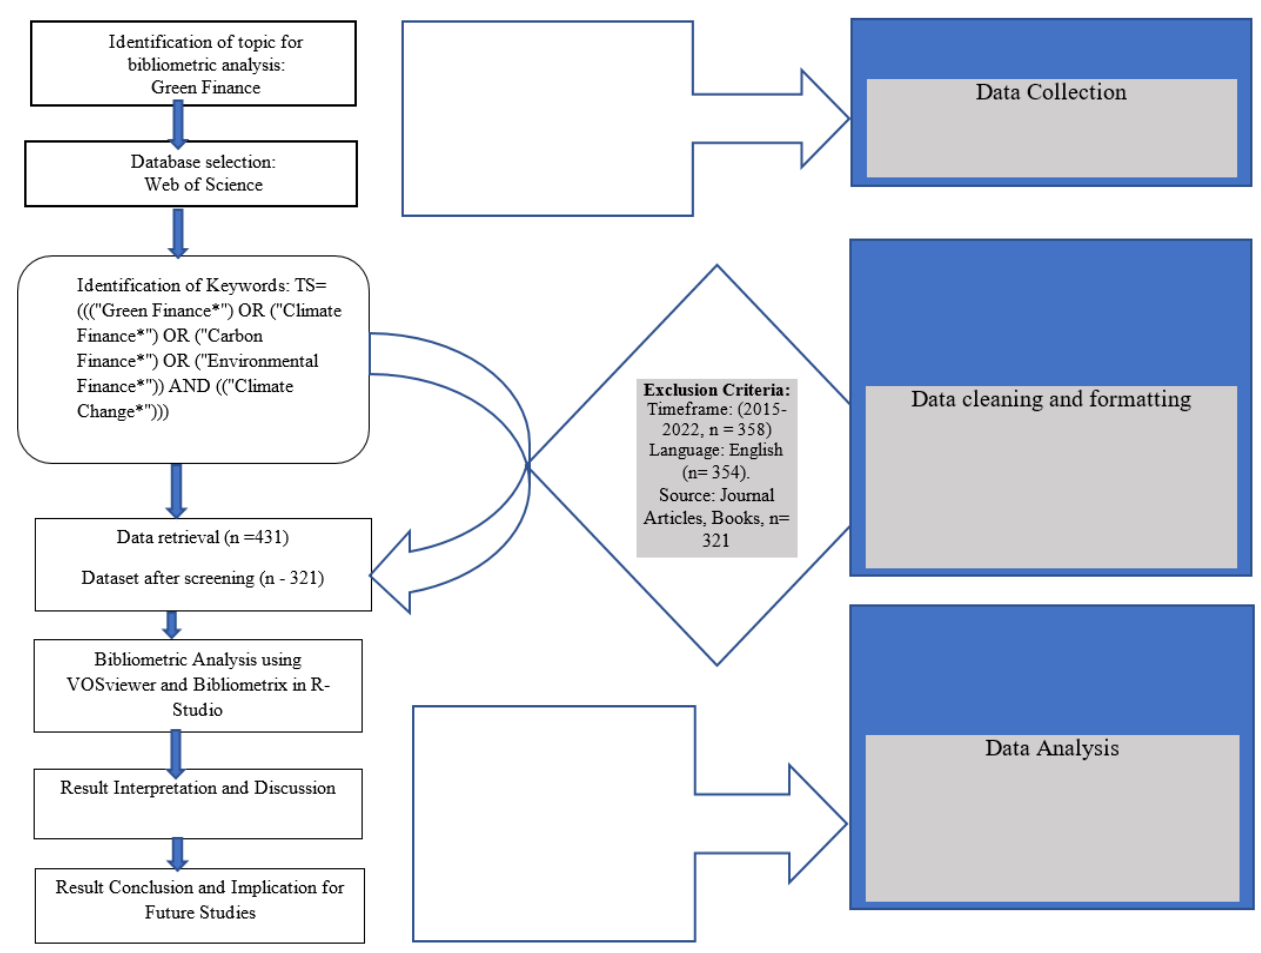
Figure 1. Summary of the research process adopted. Source: Authors’ own compilation on the research process adopted.